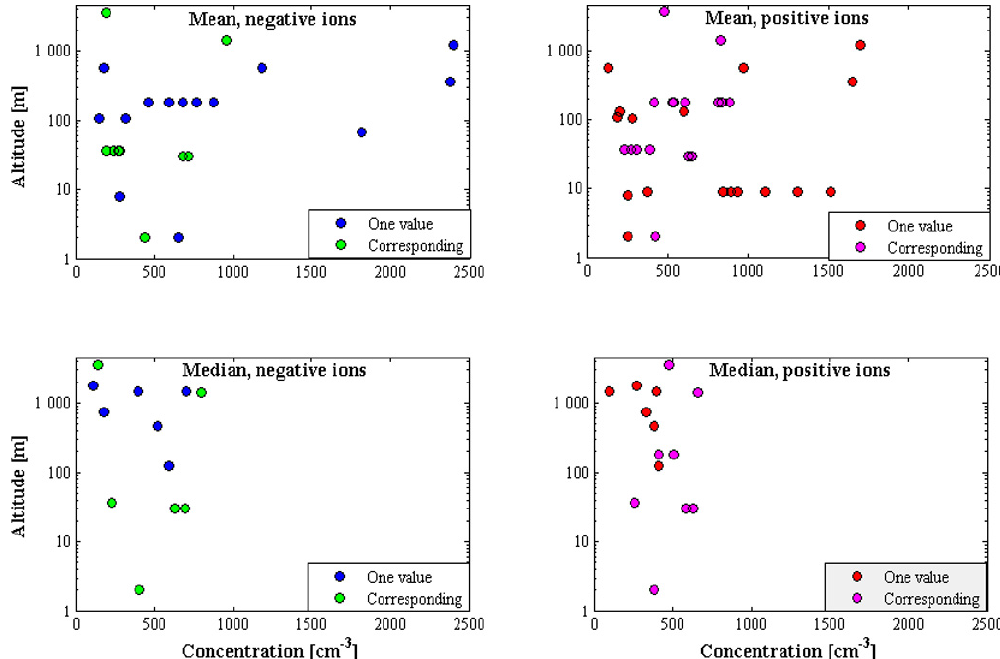
Fig. 5. The mean (top panel) and median (bottom panel) concentrations of positive (right hand side) and negative (left hand side) small ions as a function of altitude from sea level, airborne measurements are not included. The legend “Corresponding” means that both mean and median concentrations were available from specified sites.The legend “One value” means that only mean or median concentration was available. Notice that this division was made separately for both